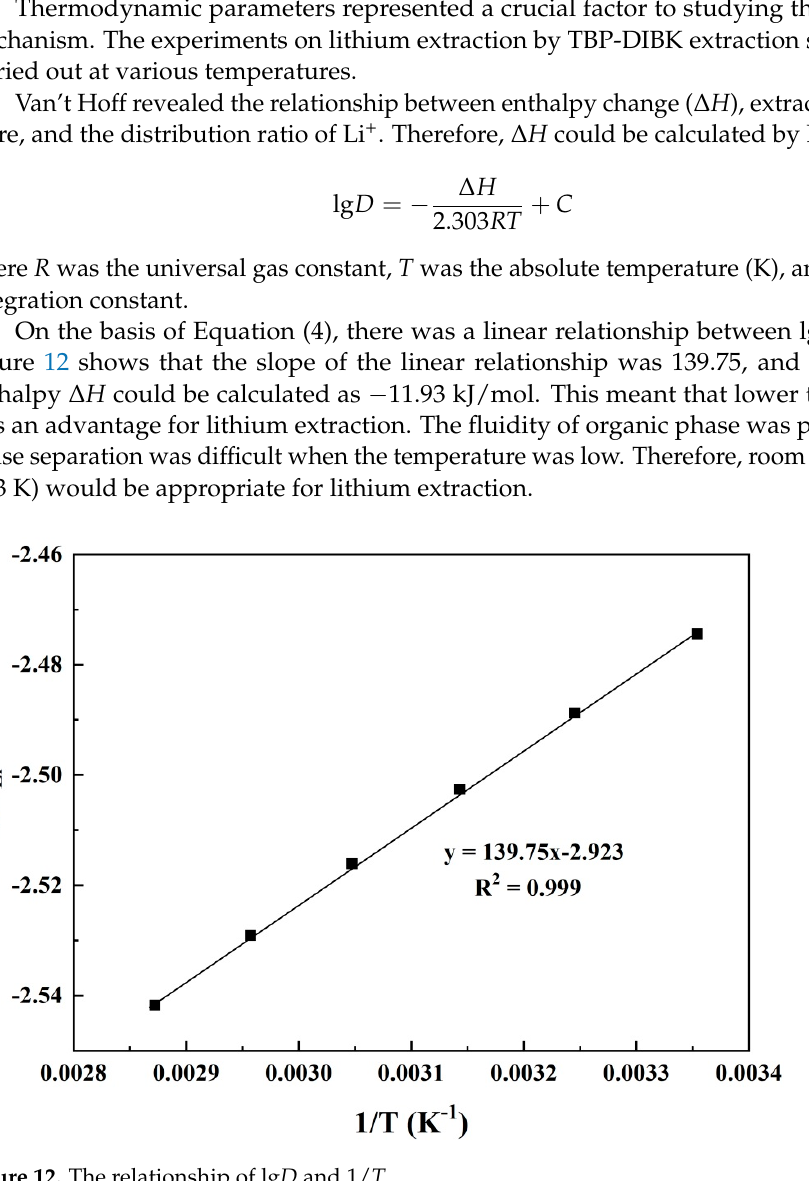
Figure 12. The relationship of lgD and 1/T.